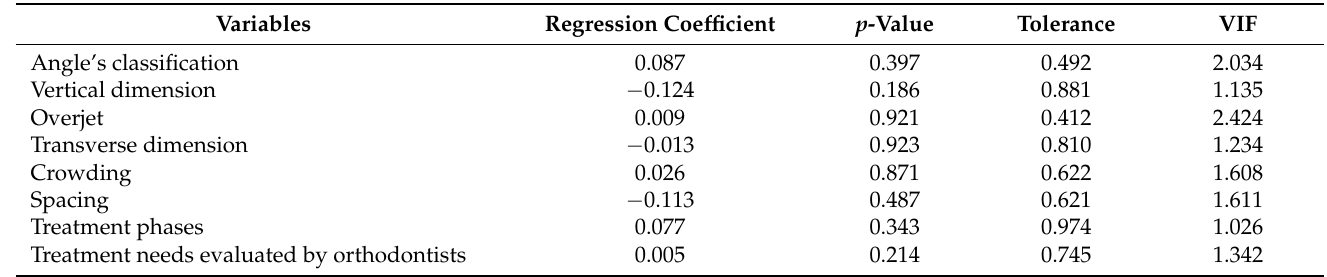
Table 6. Multiple regression analysis of the influential factors on the self-perceived treatment needs of orthodontic